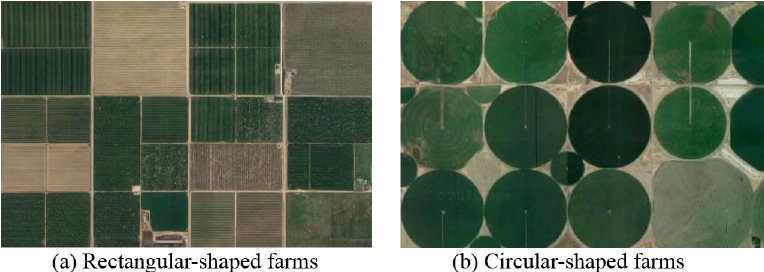
Figure 1. Aerial images showing farm shapes in Google Maps. ( a ) shows rectangular-shaped farms and ( b ) shows circular-shaped